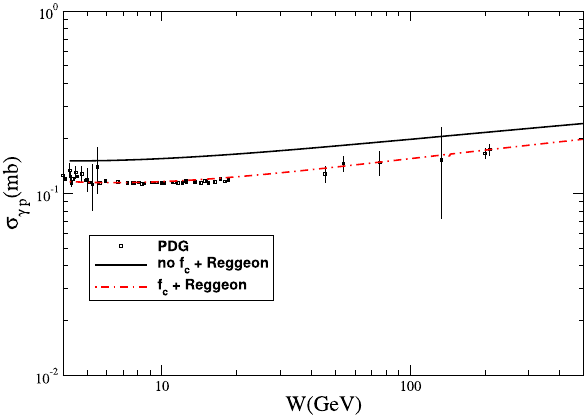
Fig. 2 Energy dependence of the photoproduction cross section cross section, σ γγ ( W 2 , Q 2